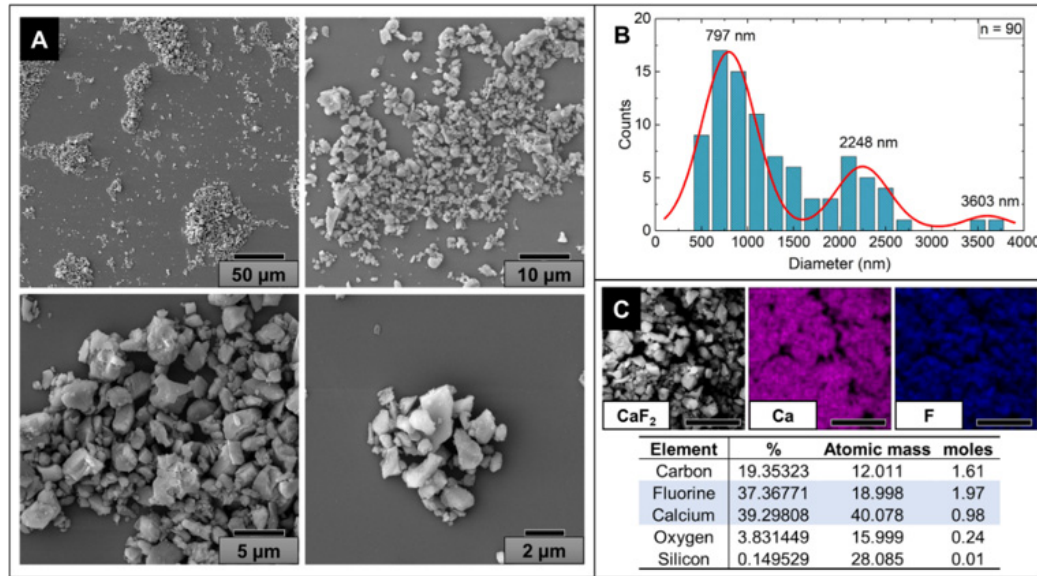
Figure 1. ( A ) SEM micrographs of part -CaF 2 at different magnifications. ( B ) Particle size distribution of part -CaF 2 ( n = 90). ( C ) EDX elemental chemical analysis of part -CaF 2 : CaF 2 (grey); Ca (red); and F (blue) (scale bar = 10 μ m).